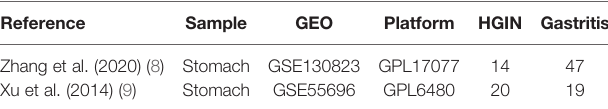
TABLE 1 | Details for GEO early gastric cancer